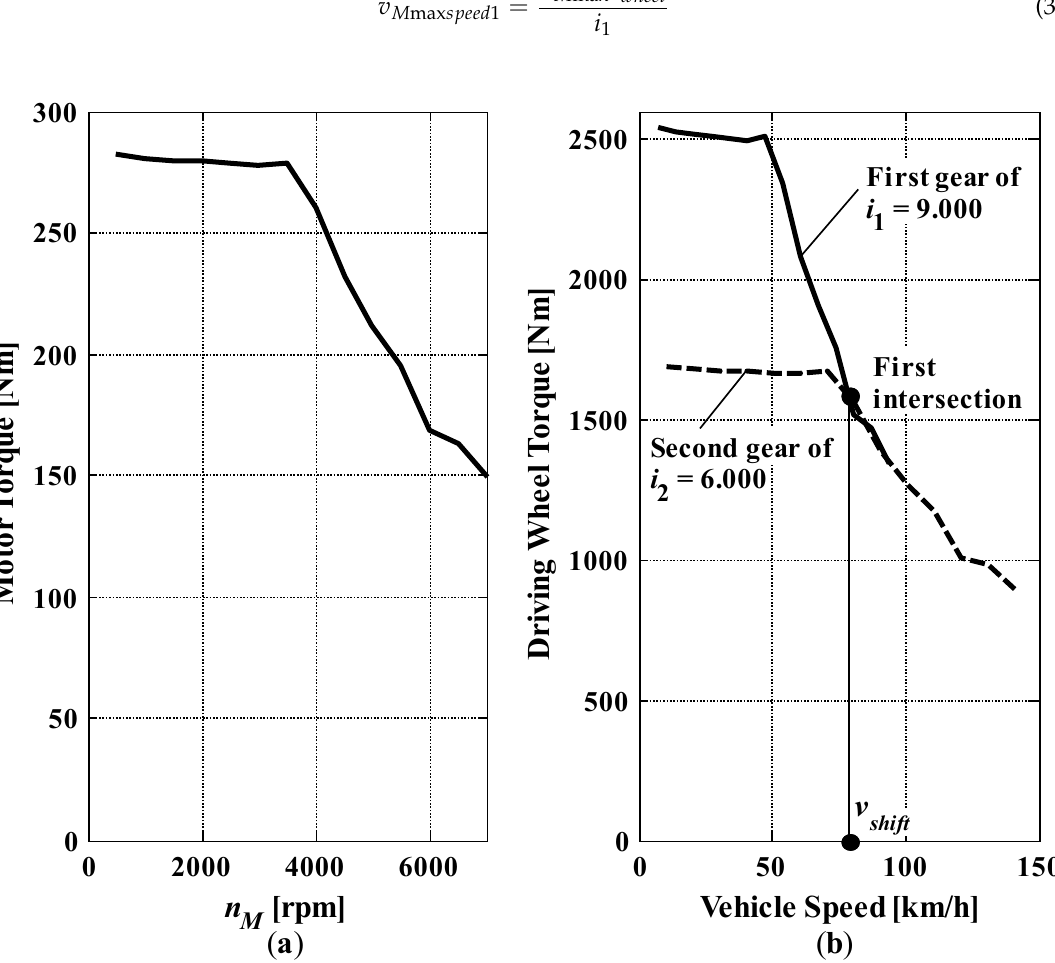
Figure 6. Example of the conversion from the motor torque-to-speed external characteristic to the vehicle torque-to-speed external characteristics: ( a ) motor torque-to-speed external characteristic; and ( b ) vehicle torque-to-speed external characteristics of the first and the second gear.